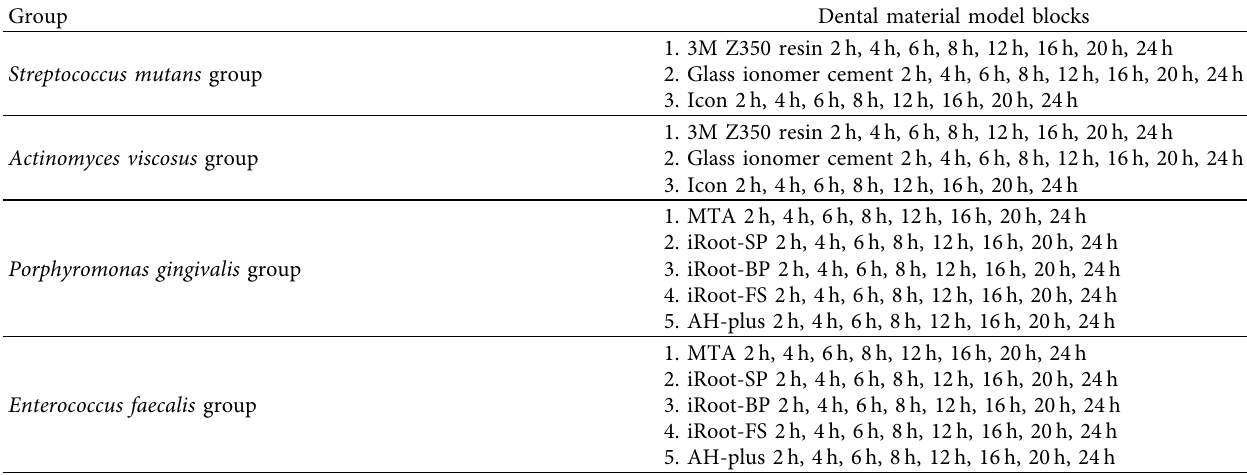
Table 2: The group of dental material model blocks and the processing time.